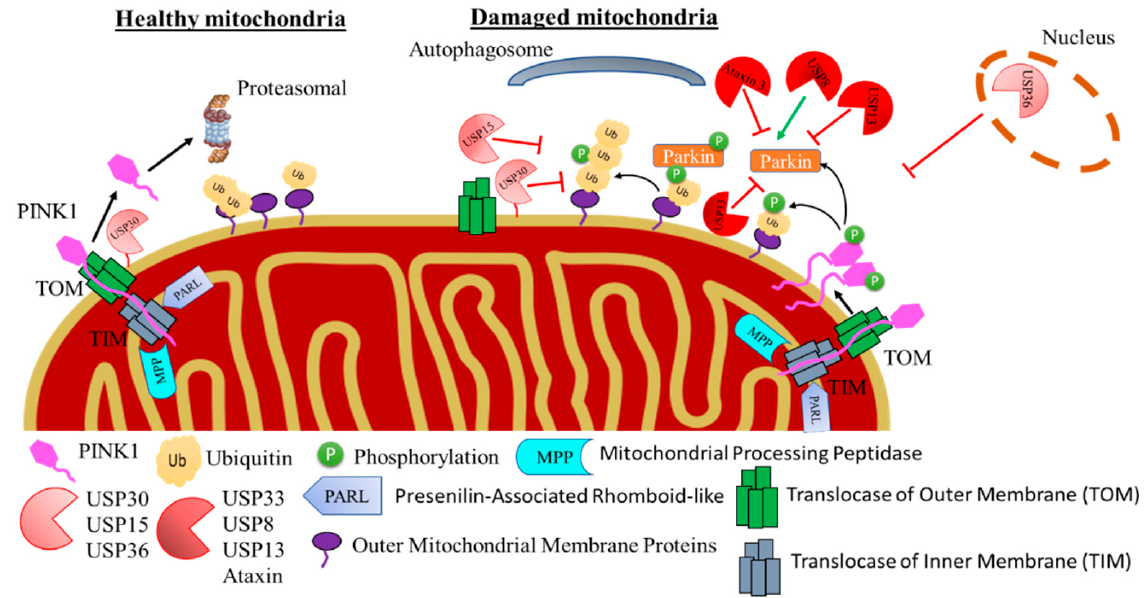
Figure 2. PINK1/Parkin-mediated mitophagy. In healthy mitochondria, the phosphatase and tensin homolog (PTEN)-induced kinase 1 (PINK1) is imported into the mitochondria via the Translocase of the Outer Membrane (TOM) and Translocase of the Inner Membrane (TIM) complexes. When the mitochondrial membrane potential is intact, PINK1 will be cleaved by two proteases (mitochondrial processing peptidase (MPP) and presenilin-associated rhomboid-like (PARL)) and translocate to the cytosol for proteasomal degradation. On the other hand, in damaged mitochondria the membrane potential is disrupted, which leads to the stabilisation and dimerisation of PINK1 in the OMM, which results in the autophosphorylation and activation of PINK1. The activated PINK1 phosphorylates pre-existing Ub substrates in the OMM, which results in the recruitment and phosphorylation of Parkin to the OMM. Phosphorylated Parkin further ubiquitinates proteins in the OMM, which leads to the coating of the OMM with Ub and the consequent recruitment of the autophagosome to the damaged mitochondria. Several DUBs have been identified as key regulators of the pathway.